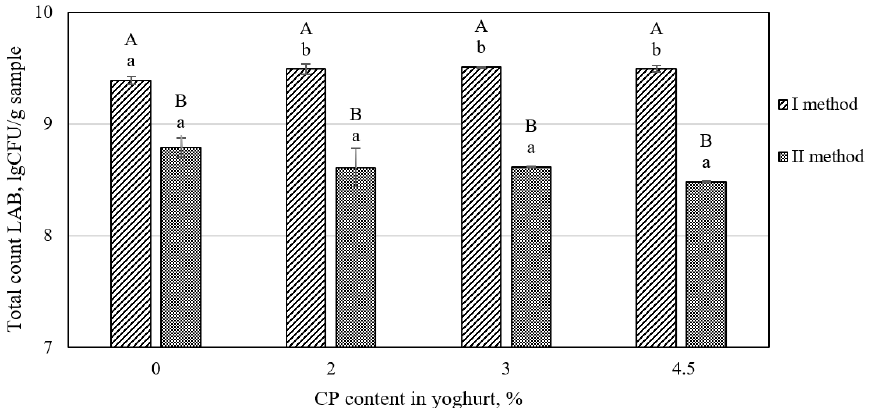
Figure 5. Viability of lactic acid bacteria (LAB) in yogurt made by adding different amounts of CP after (I method) and before fermentation (II method). Values are reported as means ± standard deviation; lower case letters indicate significant ( p < 0.05) differences between different CP content in yogurt; upper case letters indicate significant ( p < 0.05) differences between different CP addition methods.